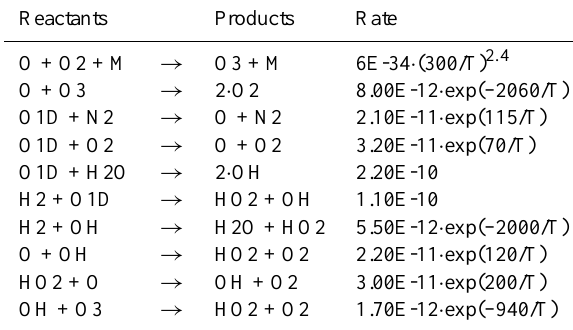
Table 3. Gas-phase reactions. ( { CO2 } indicates CO2 is not included in the model